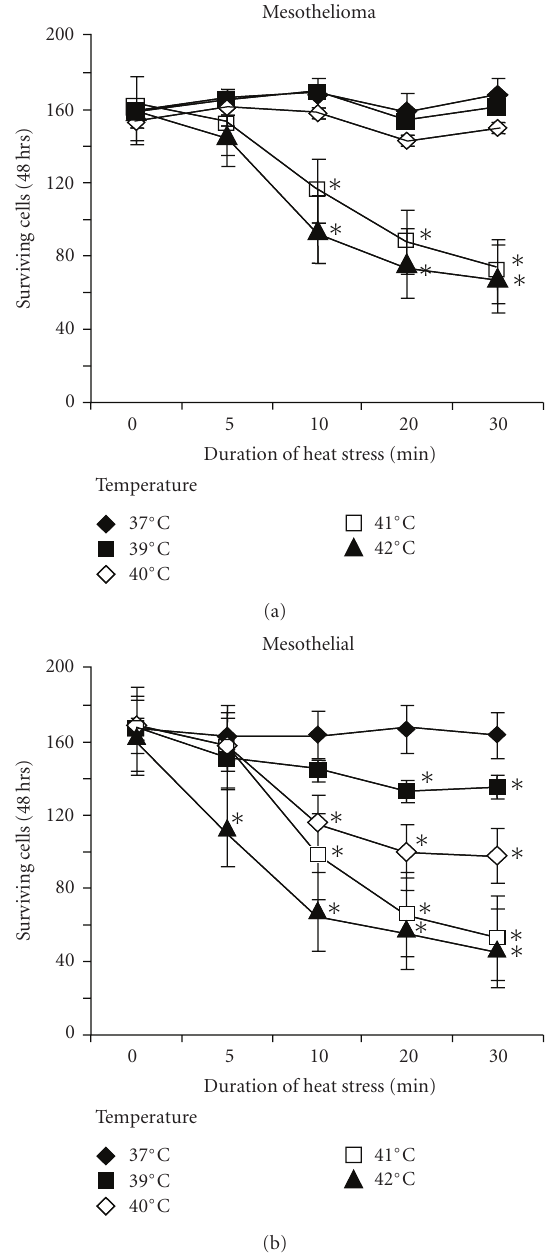
Figure 1: Heat stress induced cell death in (a) mesothelioma cell lines ( n = 3) and (b) one mesothelial cell line. Viability was determined by manual cell counting of trypan blue exclusion stained cells 3 days after heat stress. ∗ indicates P < . 01 compared to cells at 37 ◦ C. Each data point represents the mean ± S.E.M.of three independent experiments in each cell